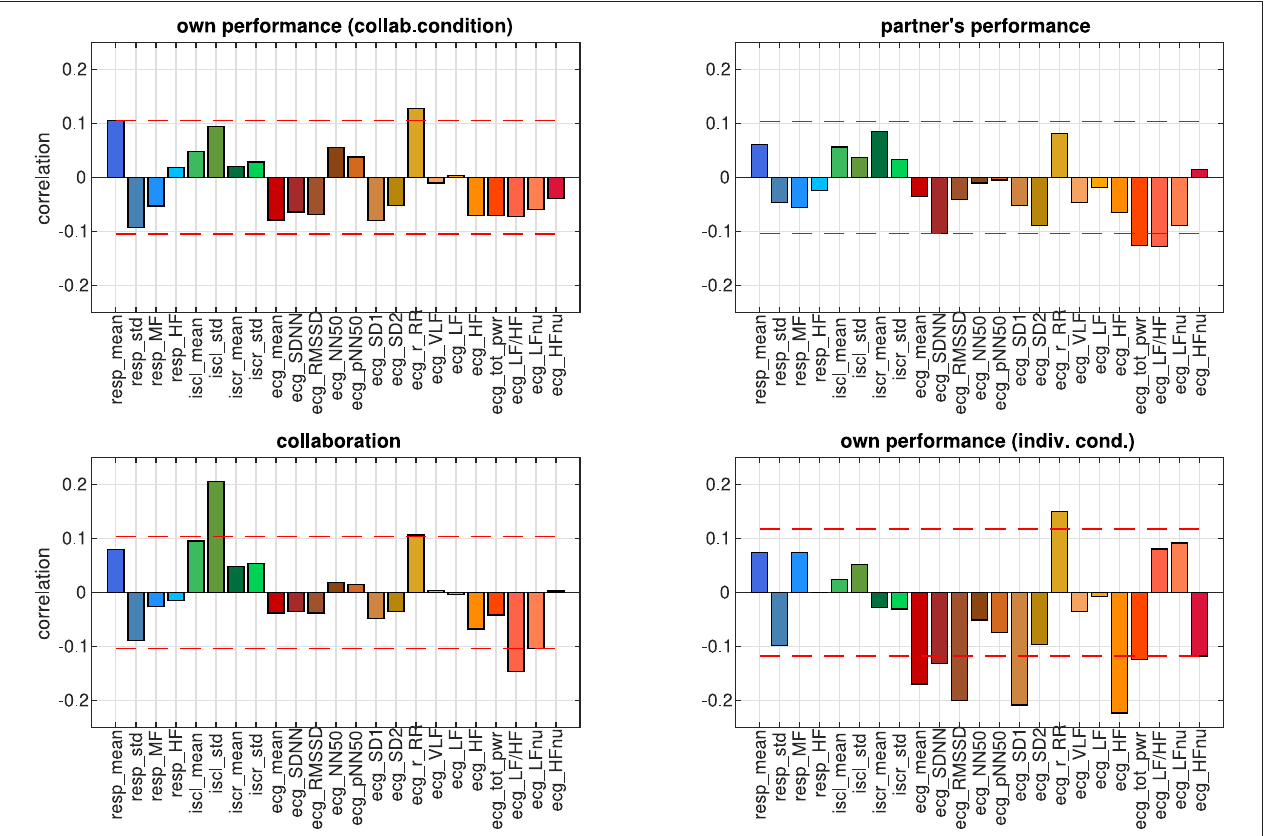
FIGURE 6 | Correlation coefficients between individual autonomic parameters and ratings. RR parameters have blue hues, EDA parameters green colors, and HRV parameters shades of red. Dashed red lines visualize the strength beyond which correlations are significant ( p < 0.05,